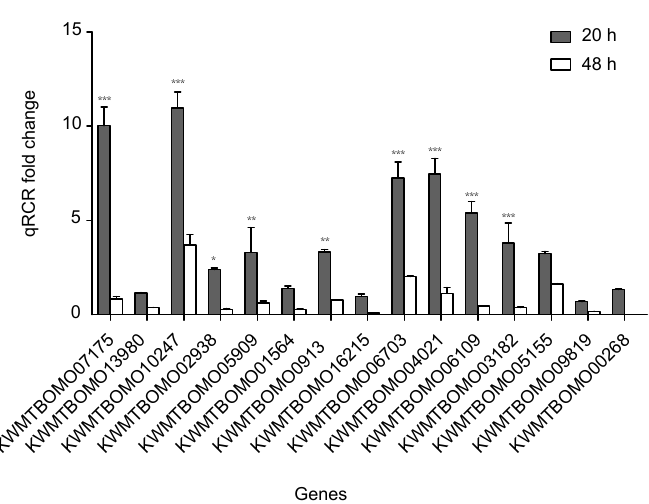
Figure 5. Quantitative real-time polymerase chain reaction (qPCR) of di ff erentially expressed genes in silkworm diapause eggs at 48 h versus that at 20 h after oviposition. Relative gene expression was normalized against reference gene tif-4A (KWMTBOMO02081). *, p < 0.05; **, p < 0.01; and ***, p <